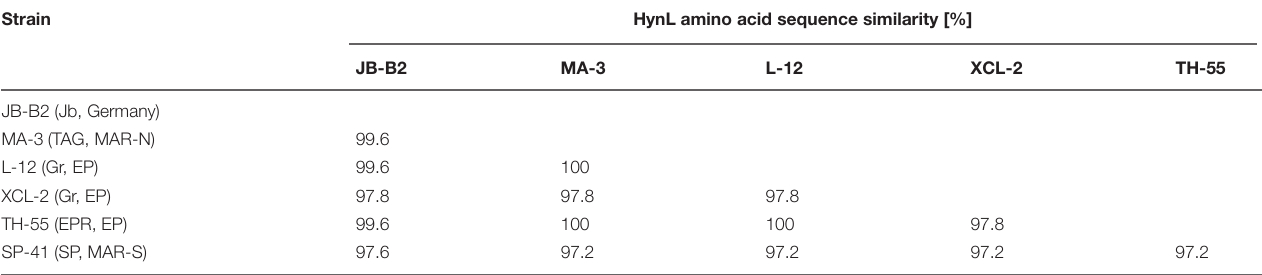
TABLE 3 | Similarities of the amino acid sequence of all cluster II hydrogenases. Strain HynL amino acid sequence similarity